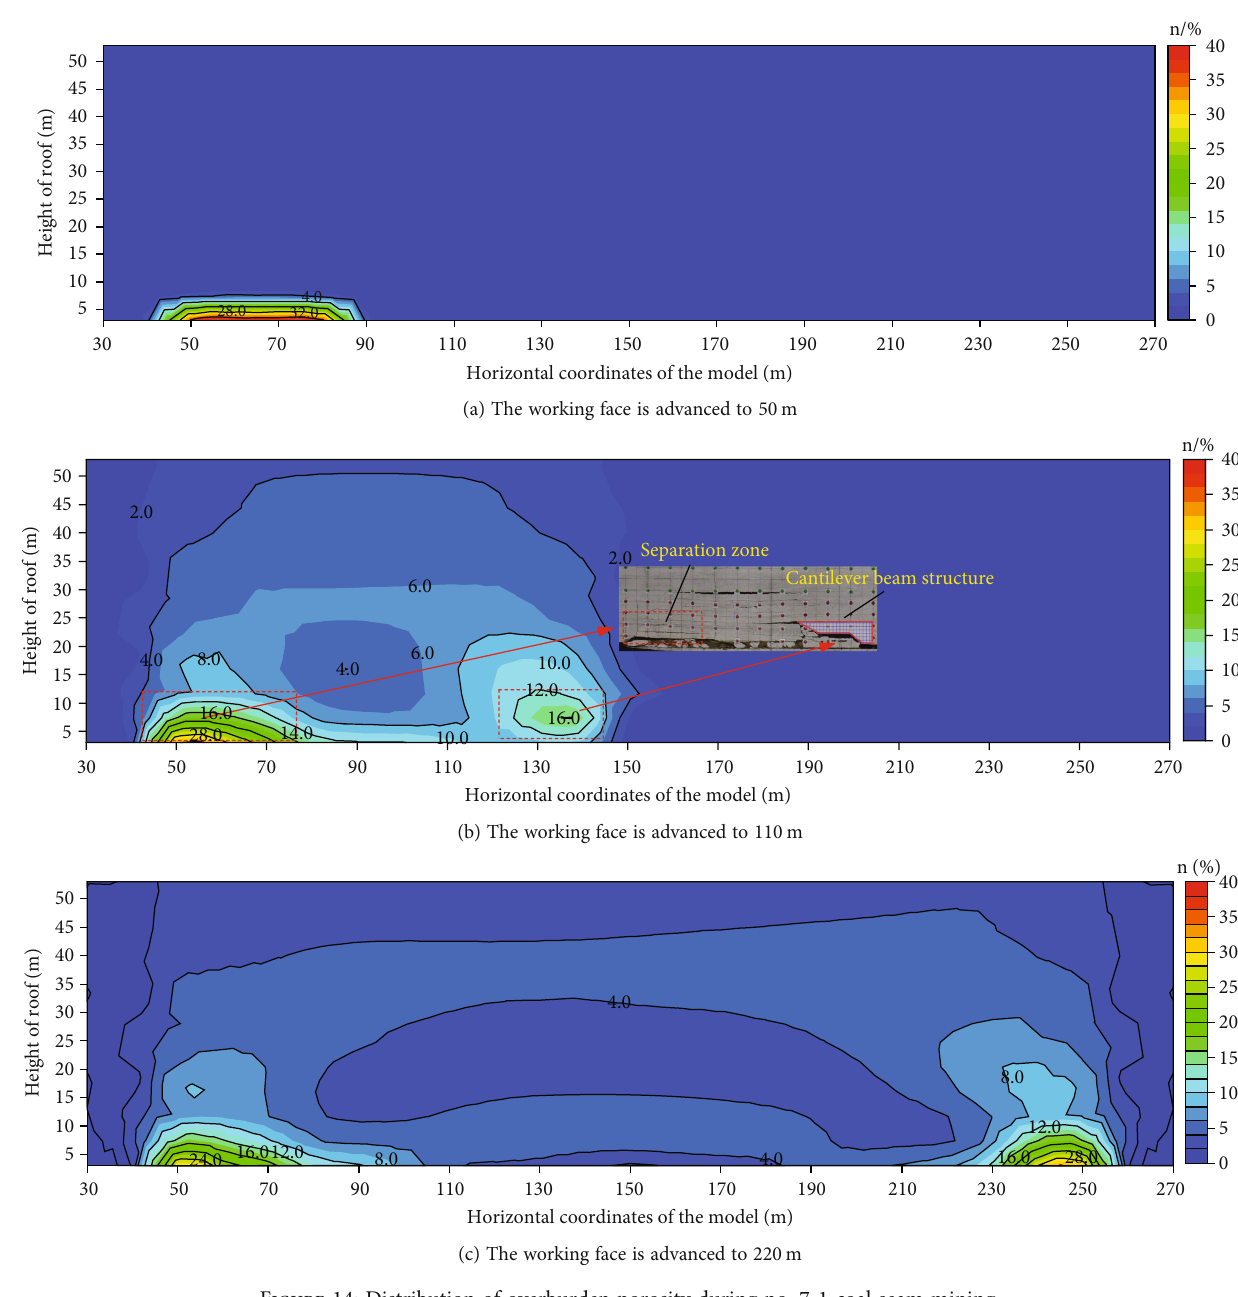
Figure 14: Distribution of overburden porosity during no. 7-1 coal seam